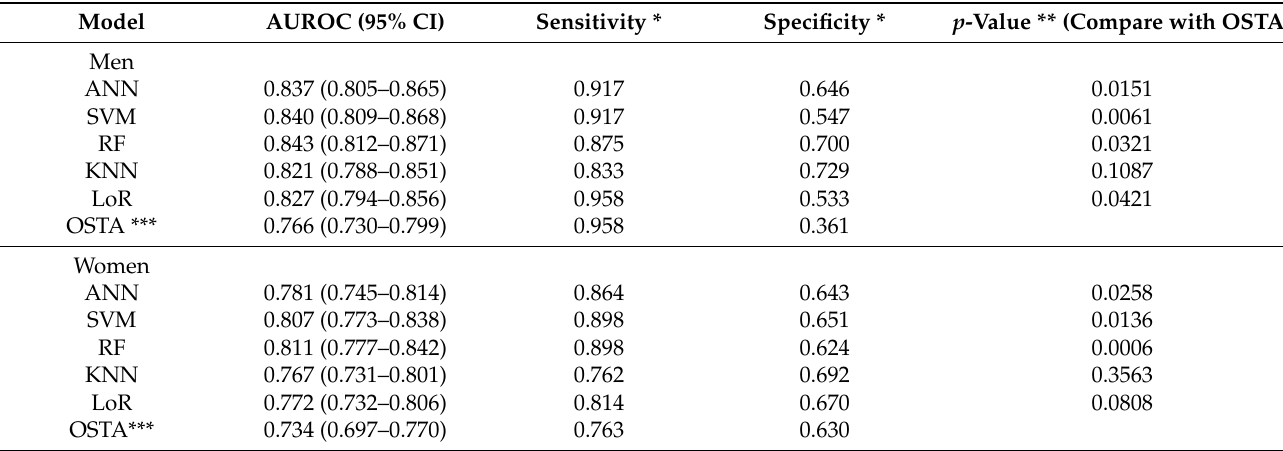
Table 4. Performance of different machine learning models and the OSTA model for prediction of osteoporosis in men and